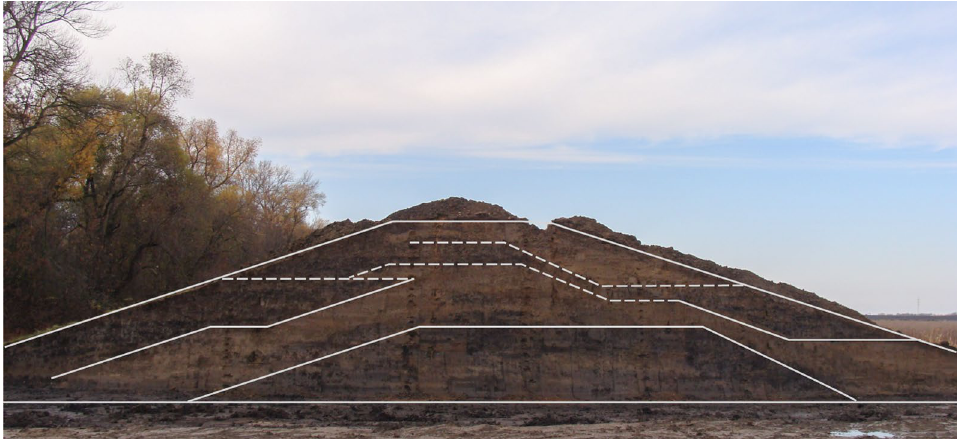
Fig. 1 Onion shell structure discovered during the relocation of a dike near, Fokorú-puszta (Tisza right bank, north of Szolnok) (authors